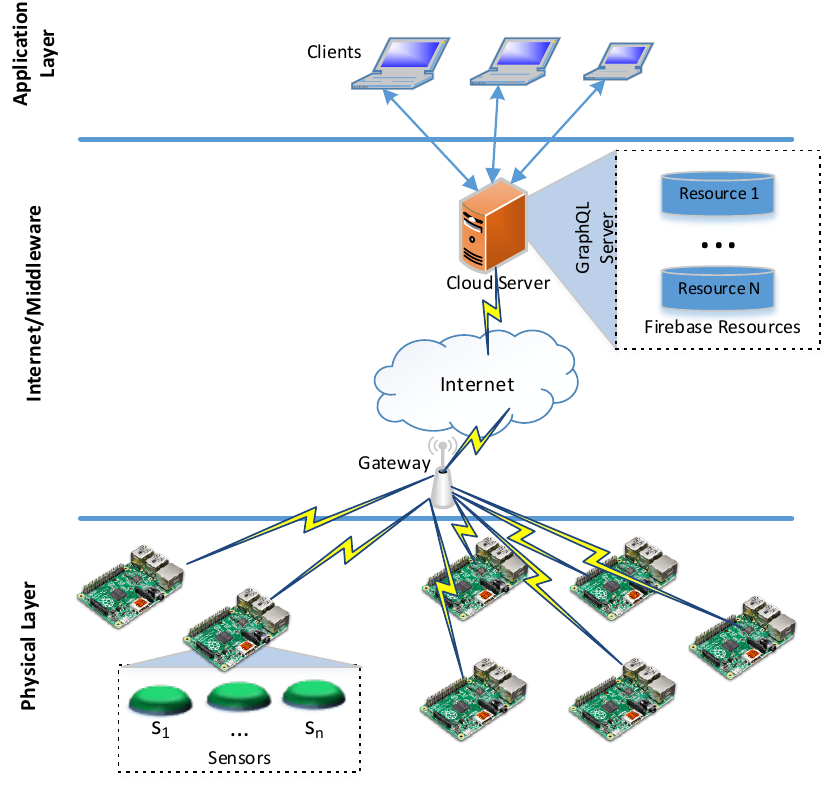
Figure 6. Layered setup of the proposed architecture for supporting IoT sensing